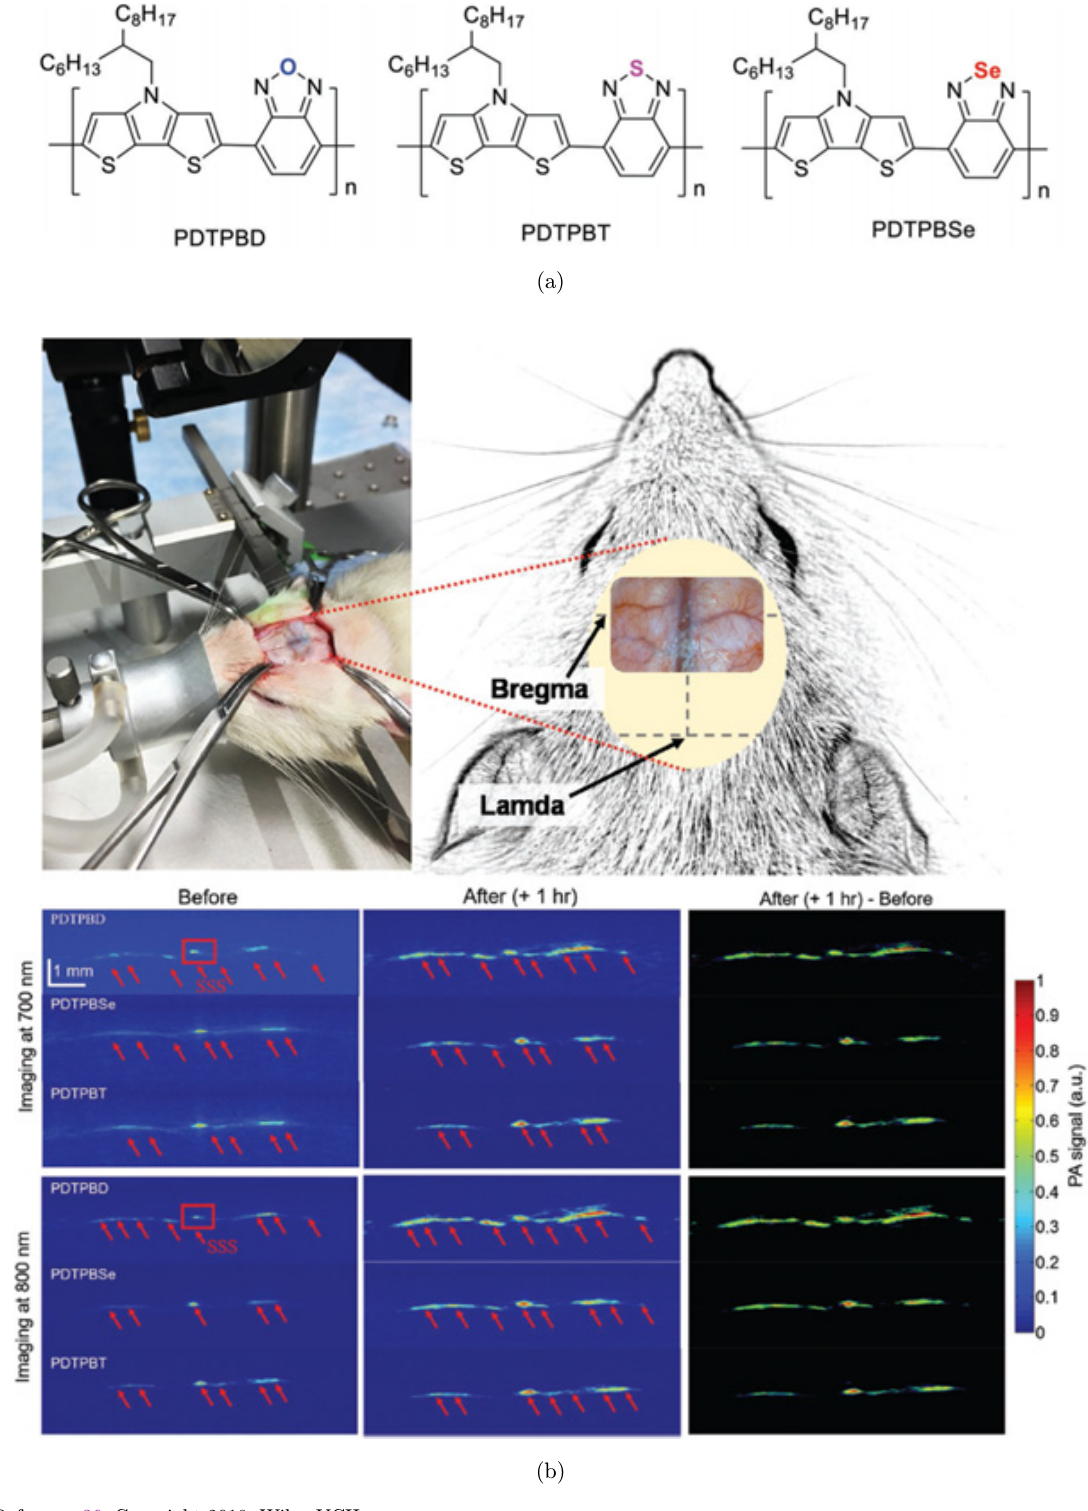
Fig. 2. PAI of rat brain vasculature structures using CPNs at 700 and 800 nm,